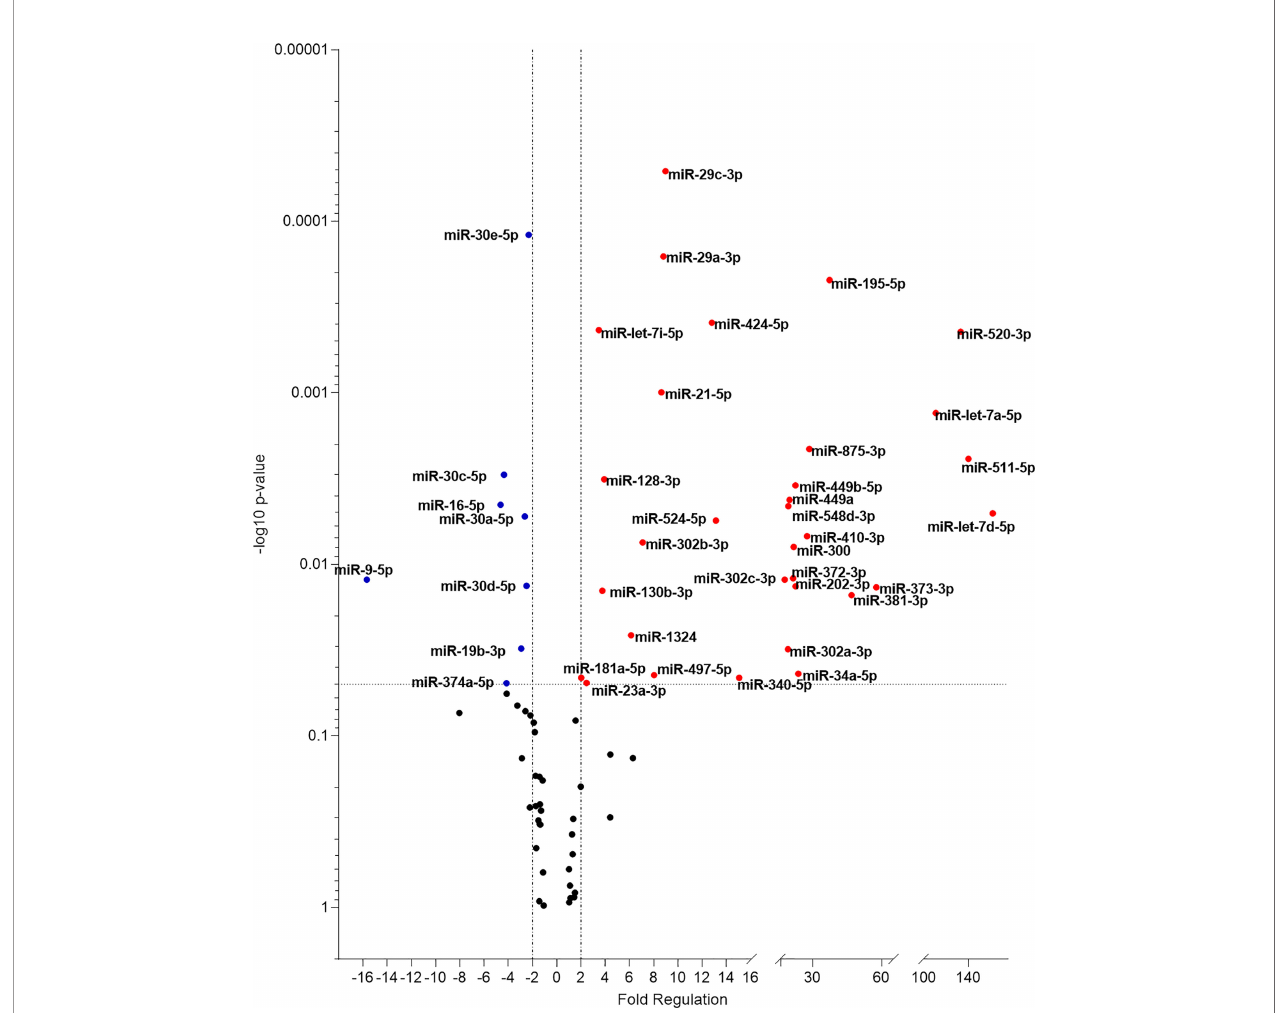
FIGURE 2 | Volcano plot of differential expression of miRNA in plasma from VL patients. Volcano plot showing differential expression of miRNA in plasma samples of active VL patients compared to healthy individuals. Each dot represents one miRNA. Red dots indicate up-regulated miRNAs, and blue dots represent downregulated ones (P < 0.05). The horizontal black dotted line corresponds to p=0.05, log 10. The relative up- and down-regulation of miRNAs, are expressed as boundaries of 2 or -2, of Fold Regulation respectively. P-value was determined based on a two-tailed Student ’ s t-test. P < 0.05 (Student t -test and Bonferroni correction).